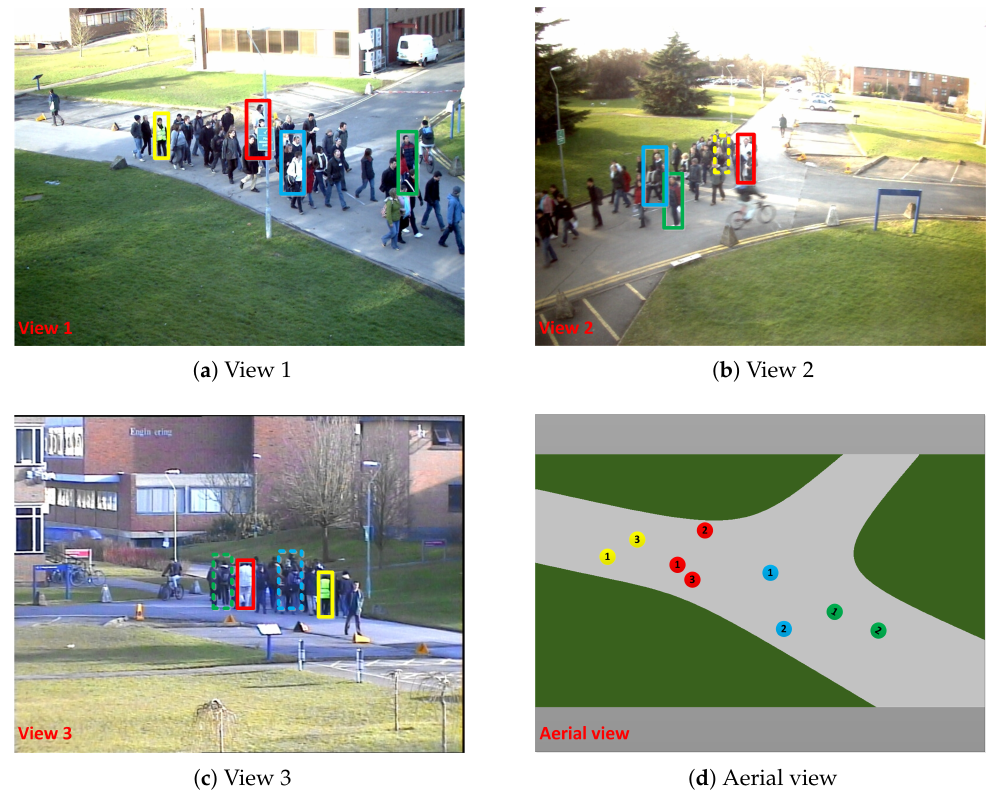
Figure 1. Occlusions in a multi-camera system. ( a – c ) Images of the 233rd frame from the first, second, and third views in PETS2009 S2.L3, respectively. These three images jointly illustrate the severe occlusions caused by dense crowds and the consequent deviations in detection. The solid-line bounding box is the detection result, while the dotted-line bounding box is the expected result of the occluded objects. ( d ) The positions of objects in aerial view produced by multi-view 3D reconstruction. Due to the presence of detection noise, the multi-view reconstruction results of each object do not coincide